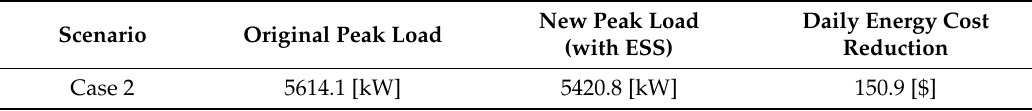
Table 10. Summary of Case 2 simulation results.